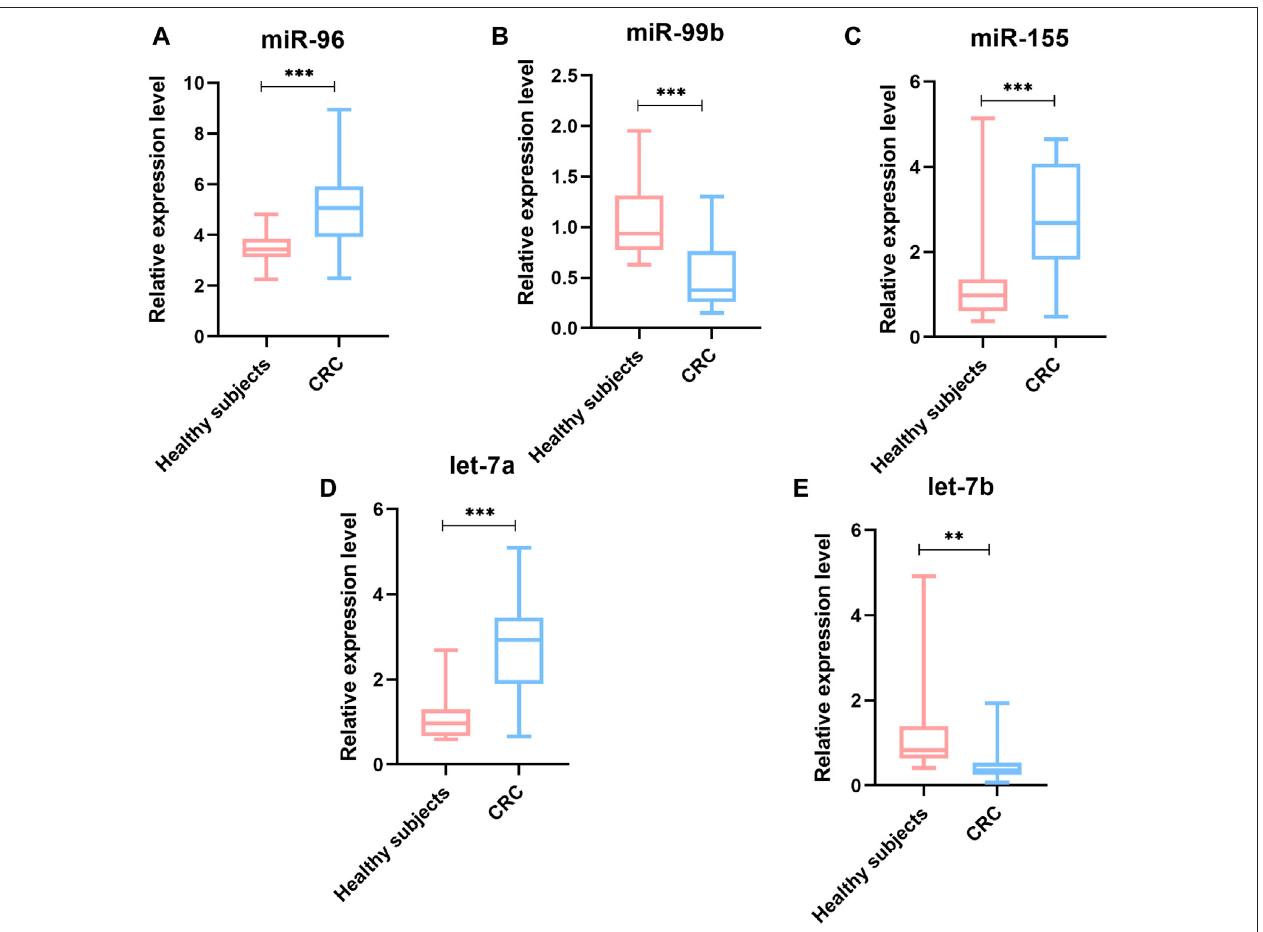
FIGURE3| TherelativeexpressionlevelofmiRNAsinplasmasamples(90CRCand20controls). (A) miR-96; (B) miR-99b; (C) miR-155; (D) Let-7a; (E) Let-7b;* p value ＜ 0.05, ** p value ＜ 0.01 and *** means p value ＜ 0.001.